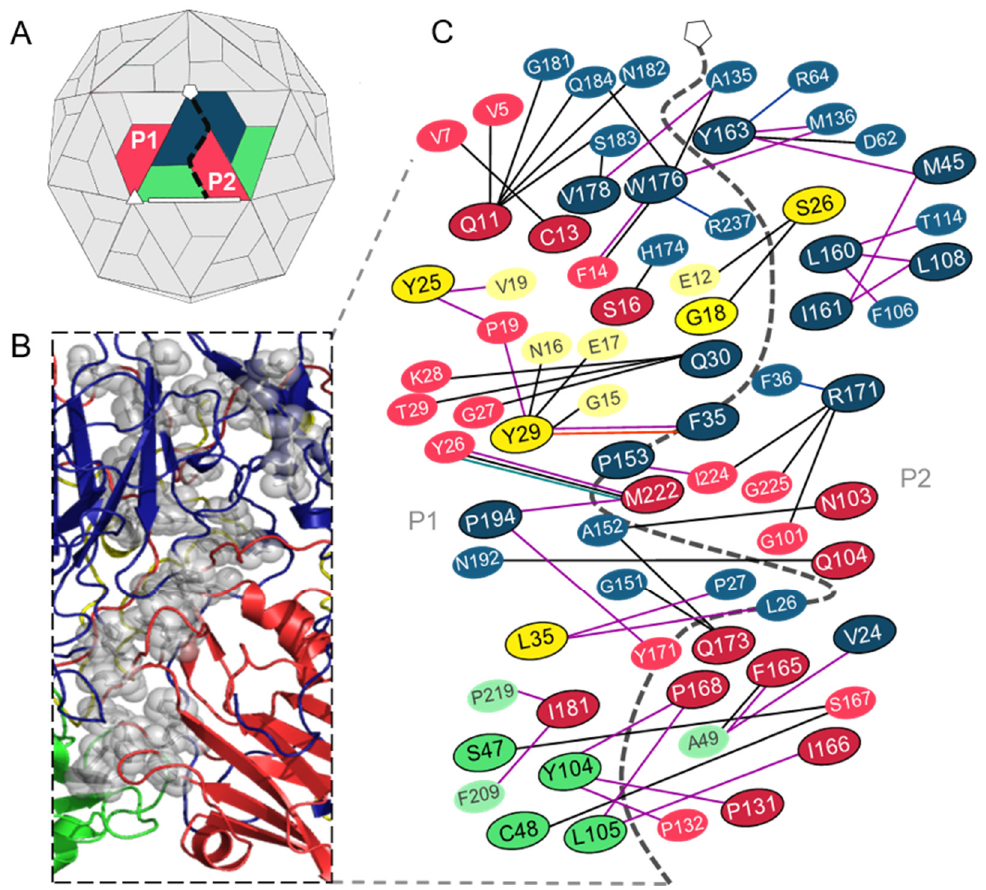
Figure 5. Hotspot residues and their interacting partners at the interprotomer interfaces of the TMEV capsid. ( A ) Structure of the picornavirus capsid showing two protomers within a pentamer that form the interprotomer interface (dashed black line). ( B ) Structural cartoon mapping of predicted hotspot residues (shown as grey spheres) at the interprotomer interfaces. ( C ) Network of hotspot residues and the contacts made with their residue binding partners at the interprotomer interface. Hotspot residues are outlined in black; partner non-hotspots are not outlined. VP1 residues (blue); VP2 residues (green); VP3 residues (red); VP4 residues (yellow). Noncovalent interactions between hotspots and partners are shown as solid lines: hydrogen bonds (black lines); hydrophobic (purple lines); aromatic (orange lines); aromatic–sulphur (turquoise lines); and cation–pi (blue lines) interactions. Table 5. Interprotomer hotspot residues in TMEV with previously known functions. Known Function Ref.